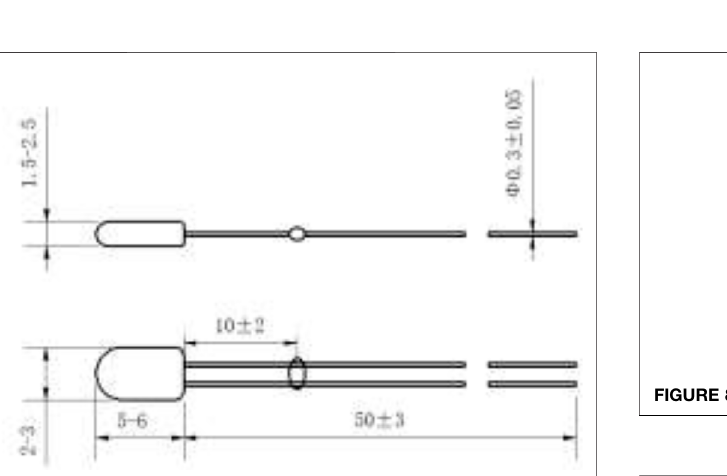
FIGURE 6 | Schematic diagram of the temperature measurement sensor.